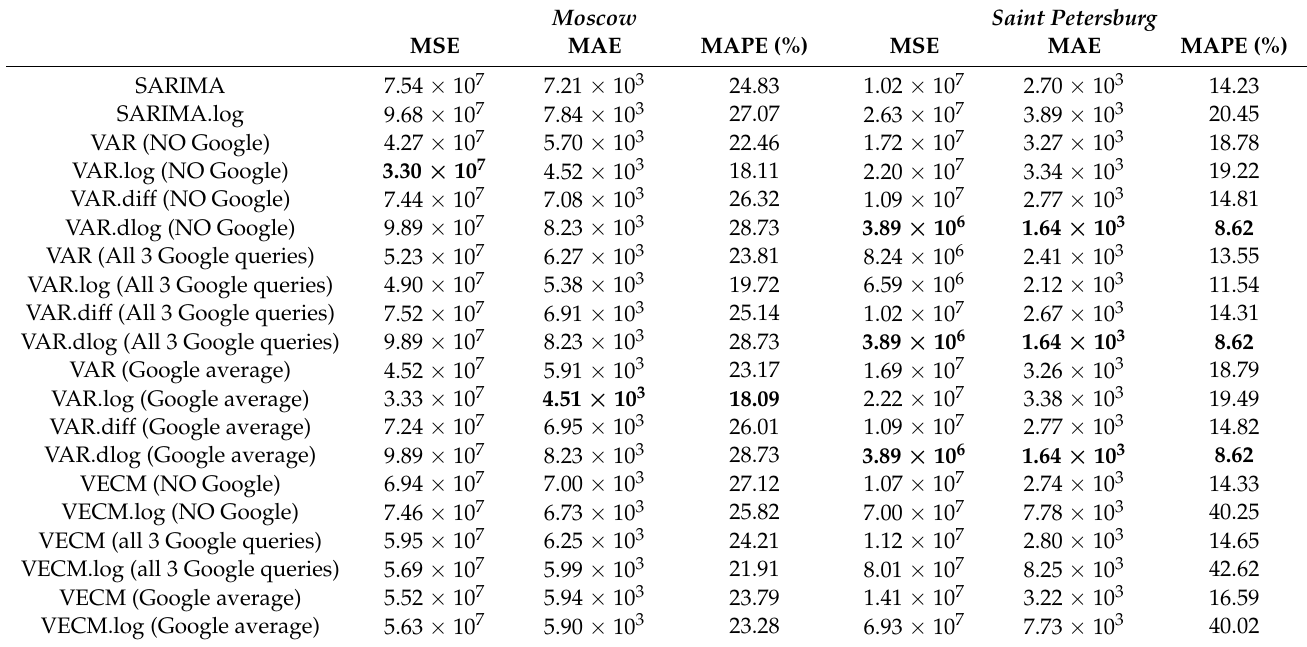
Table 6. Models’ performances according to the mean squared error (MSE), the mean absolute error (MAE), and the mean absolute percentage error (MAPE). The smallest values are reported in bold